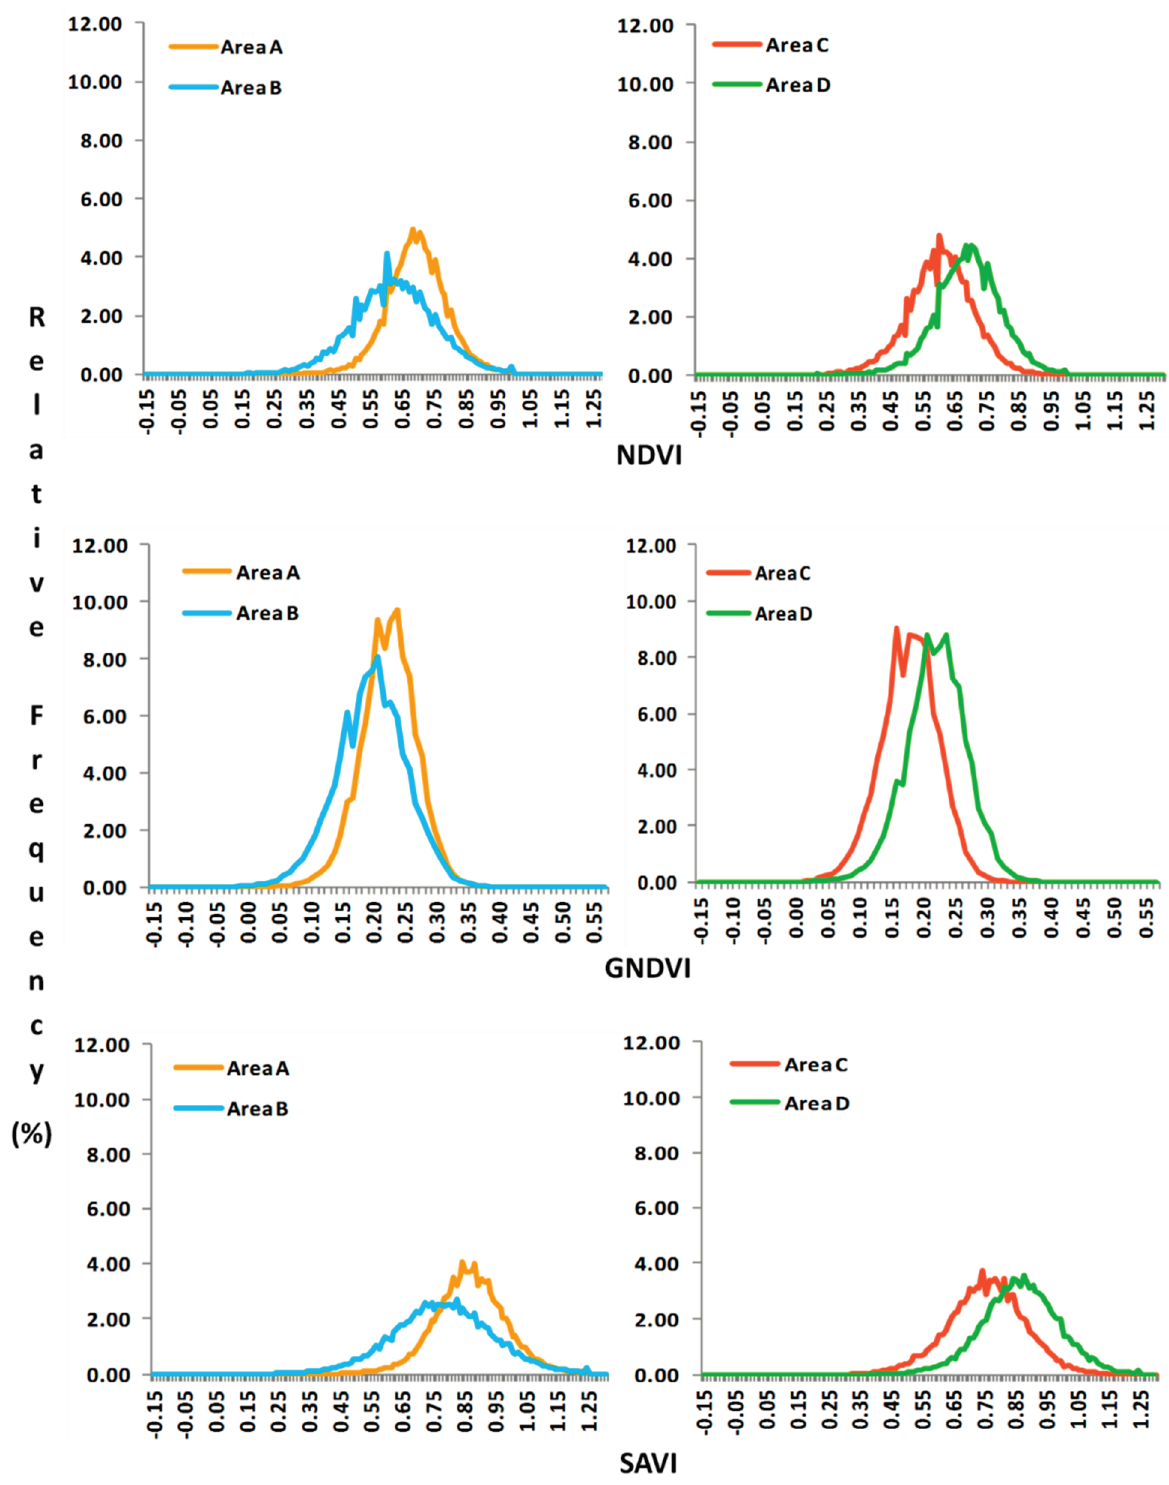
Figure 9. Relative frequency histograms of NDVI, GNDVI, SAVI indices, and values for areas A, B, C, and D. Given the different nature of the GNDVI index, a different range was used for the horizontal axis of the